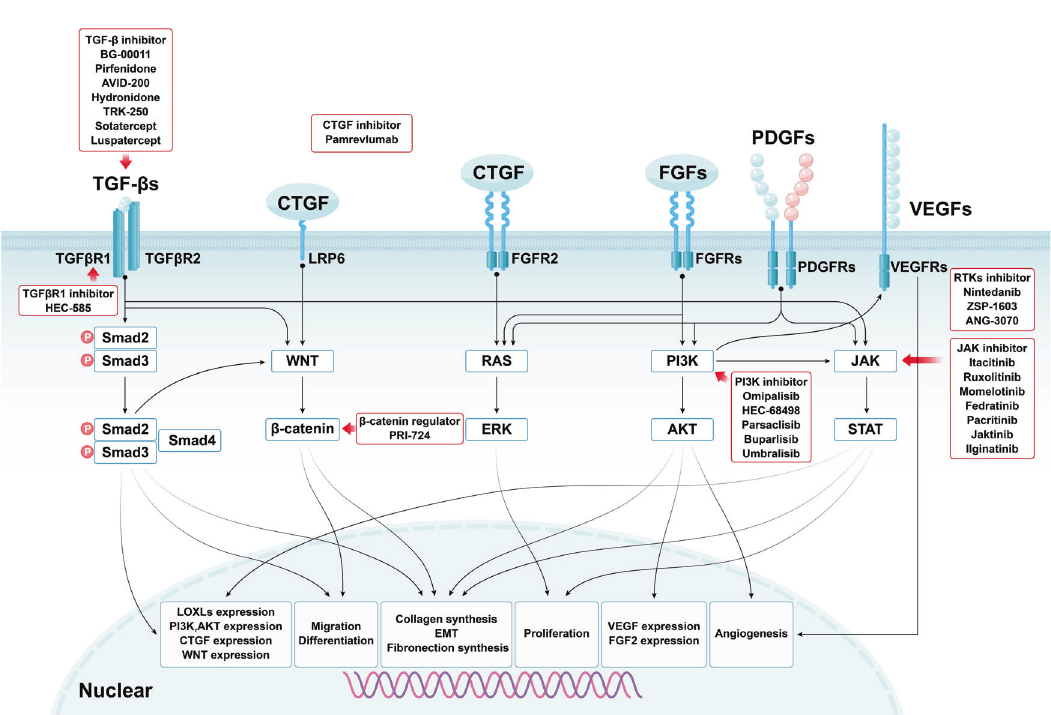
Fig. 4 Interactions between growth factors-associated signaling pathways and a summary of related target drugs. PDGFs binding to PDGFRs activates the JAK/STAT, PI3K/AKT, and RAS/ERK signals. FGFs binding to FGFRs activates PI3K/AKT and RAS/ERK signals. CTGF binding to FGFR2 (promoting FGF2 and FGF4 binding to FGFR2) activates RAS/ERK signaling, and CTGF binding to LRP6 activates WNT/ β -catenin signaling. Drugs targeting these signaling pathways are listed. EMT: epithelial-mesenchymal